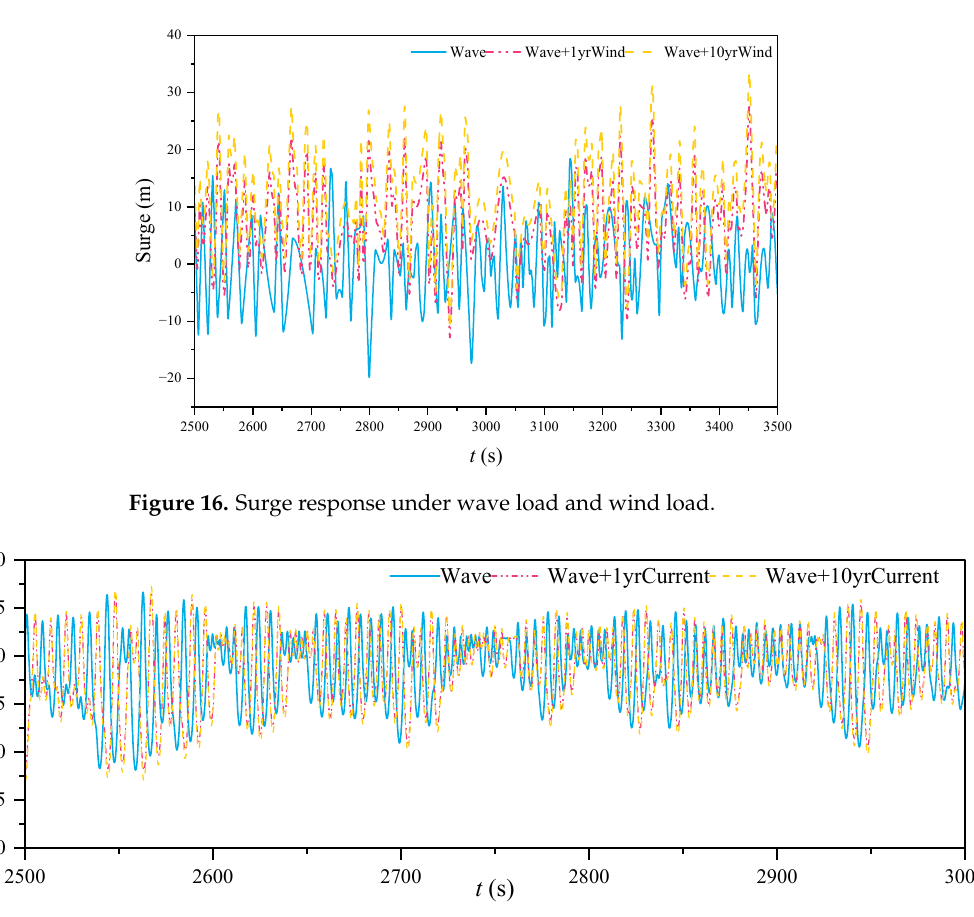
Figure 15. Surge response under wave load and current load.